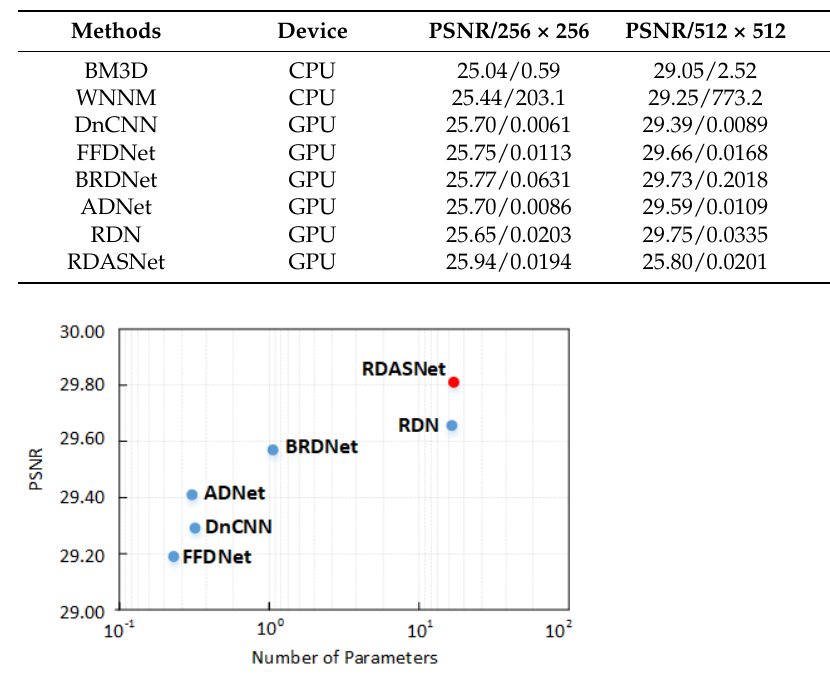
Table 8. Comparison of parameters and run times.